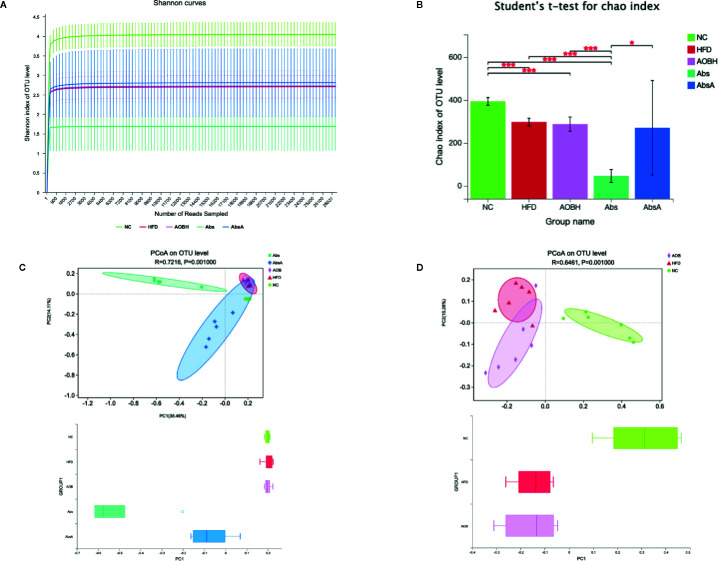
Analyzing the diversity of the gut microbiota among different groups. (A) Shannon rarefaction curve in individual groups. The abscissa shows the number of sequencing tags to be retrieved randomly, and ordinates reflect the estimated value of the Sobs index determined when a specific number of tags are retrieved. (B) Alpha diversity index (Chao estimator) analysis for each group. Student’s t-test was employed for determination of discrepancies. *p < 0.05, ***p < 0.001 compared to group. (C) Principal coordinate analysis (PCoA) for unweighted UniFrac distance metrics among NC, HFD, AOBH, Abs, and AbsA groups in gut microbiota populations. (D) PCoA for unweighted UniFrac distance metric in the gut microbiota communities among the NC, HFD, and AOBH groups.